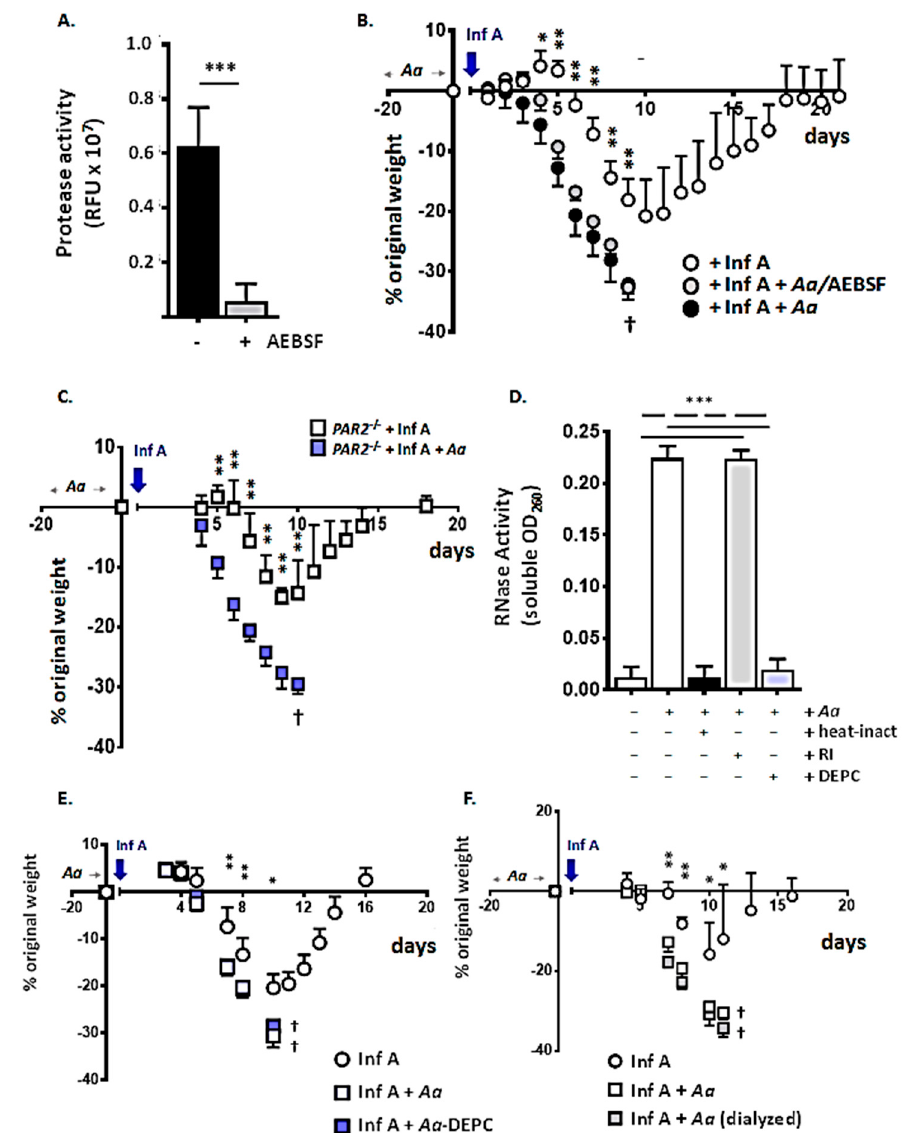
Figure 6. Serine protease activity, RNase activity, and low molecular weight biomolecules are not among the critical factors promoting the amplified lethal response to Inf A. ( A ) Treatment with the irreversible serine protease inhibitor AEBSF reduces the protease activity in filtrates from A. alternata by > 10-fold; *** p < 0.005. ( B ) Proteolytic inactivation of the A. alternata filtrate with AEBSF had no impact on its ability to promote weight loss and mortality when administered at 5 µ g per inoculum in response to a sublethal infection with Inf A; n = 5 mice per group, ** p < 0.01, † no survival after this time point in groups indicated. ( C ) Responses of Par2 gene-deleted ( Par2 - / - ) mice to Inf A alone and Inf A after repetitive inoculation with A. alternata (as per Figure 1A; 5 µ g per inoculum) are similar to those of wild-type mice; n = 5 mice per group, ** p < 0.01, † no survival after this time point in the group indicated. ( D ) Heat (95 ◦ C for 10 min) and diethylpyrocarbonate (DEPC), but not human placental ribonuclease inhibitor (RI) inhibited the ribonuclease activity in A. alternata filtrates, consistent with the profile of a T2 family enzyme (see Genbank Acc. No. XM_018531878.1); *** p < 0.005. ( E ) Ribonucleolytic inactivation of the A. alternata filtrate with DEPC has no impact on its capacity to promote weight loss and mortality (5 µ g per inoculum) in response to an otherwise sublethal Inf A infection; n = 5 mice per group, ** p < 0.01, 1-way ANOVA; † no survival after this time point in groups indicated. ( F ) Dialysis of the A. alternata filtrate to remove small biomolecules ( < 12 kDa) had no impact on the amplified lethal response to Inf A; ** p < 0.01, * p < 0.05, † no survival after this time point in the group